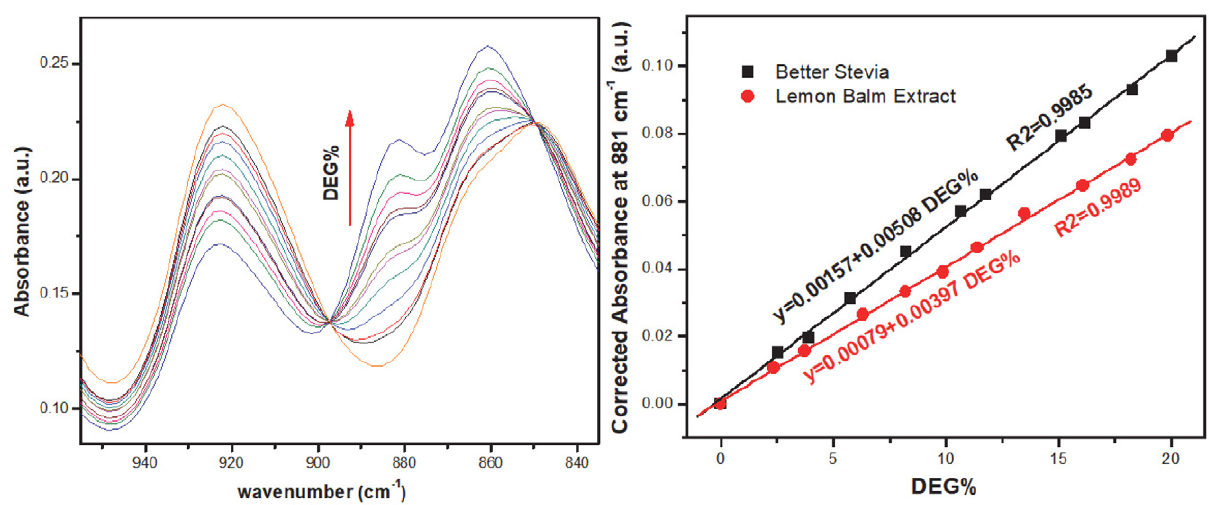
Figure 6 : FT-IR spectra of Better Stevia spiked with DEG (left) and corrected absorbance at 881 cm –1 for DEG-spiked Better Stevia and Lemon Balm Extract Table 4: Actual and predicted DEG percentages from corrected ab- sorbance at 881 cm –1 for Better Stevia. Actual DEG%